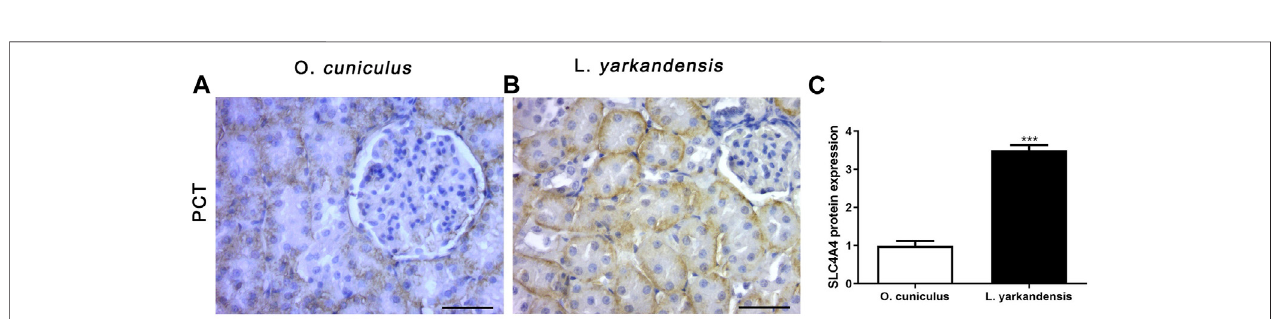
FIGURE8| SLC4A4 protein distribution inrenal PCT inatissuesection of O.cuniculus and L. yarkandensis . Paraf fi nsections (6 µm)ofrenal cortex and medullaof O. cuniculus and L. yarkandensis (A-B) . The sections were incubated with anti- SLC4A4 antibody scale bar 50 µm. Densitometry of all immunohistochemistry results of renal PCT from O. cuniculus and L. yarkandensis (n = 6 for each group), ppp p < 0.001 (C) . Average density showed a signi fi cant higher expression of SLC4A4 protein abundance in PCT of L. yarkandensis compared to that of O. cuniculus (C) .